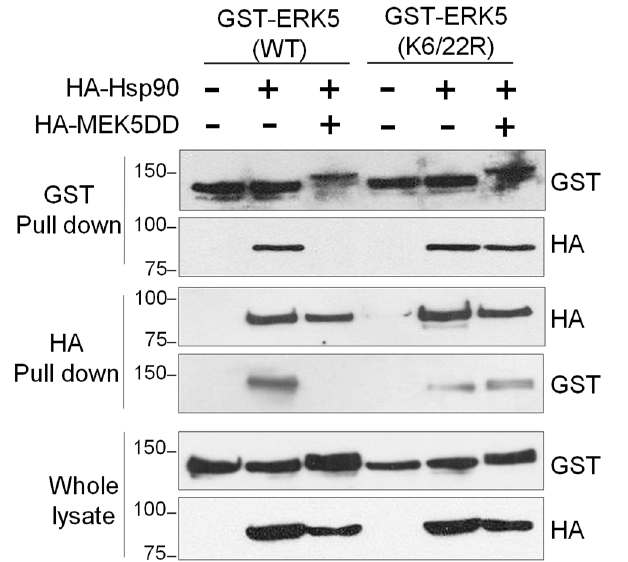
Figure 6. SUMOylation is necessary for Hsp90 dissociation from the ERK5-Cdc37 complex after MEK5 activation. HEK293T cells were transfected with GST-tagged ERK5 (wild type or SUMO-deficient K6/22R mutant) alone or in combination with Hsp90 and MEK5DD. Thirty-six hours later, cells were lysed, and GST-ERK5 or HA-Hsp90 proteins were affinity-purified using glutathione-sepharose or anti-HA agarose resins, respectively. Immune complexes were immunoblotted for ERK5 and Hsp90. Similar results were obtained in three independent